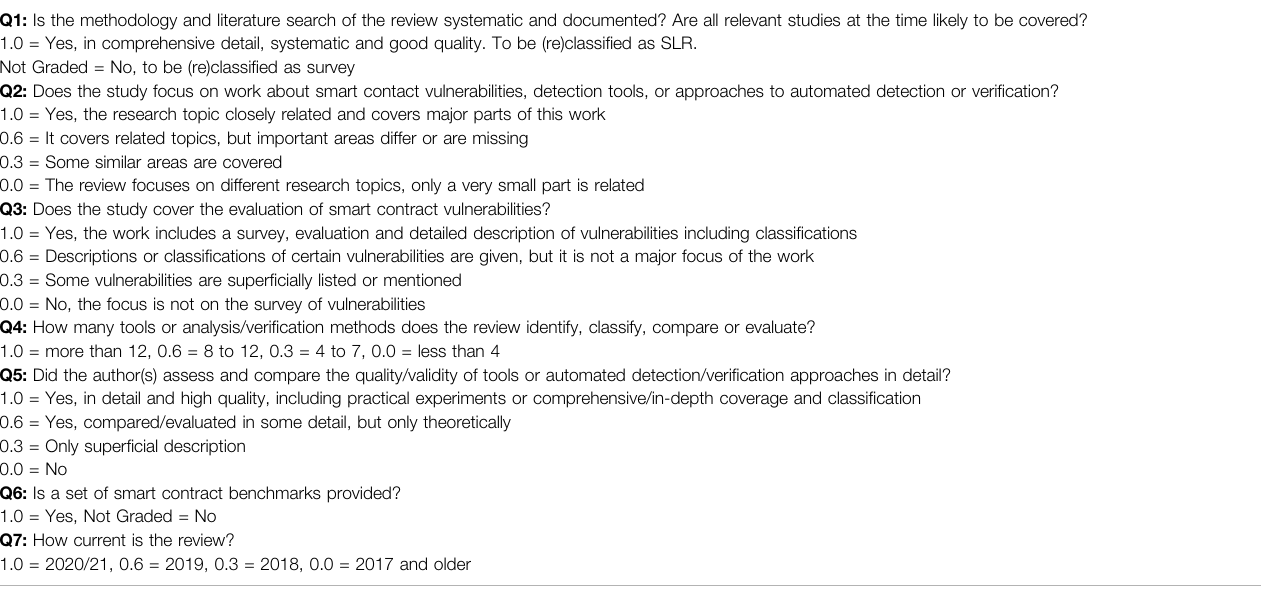
TABLE 3 | Criteria for assessing the contextual data quality (CDQ) of SLRs and surveys. Q1: Is the methodology and literature search of the review systematic and documented? Are all relevant studies at the time likely to be covered? 1.0 = Yes, in comprehensive detail, systematic and good quality. To be (re)classi fi ed as SLR.